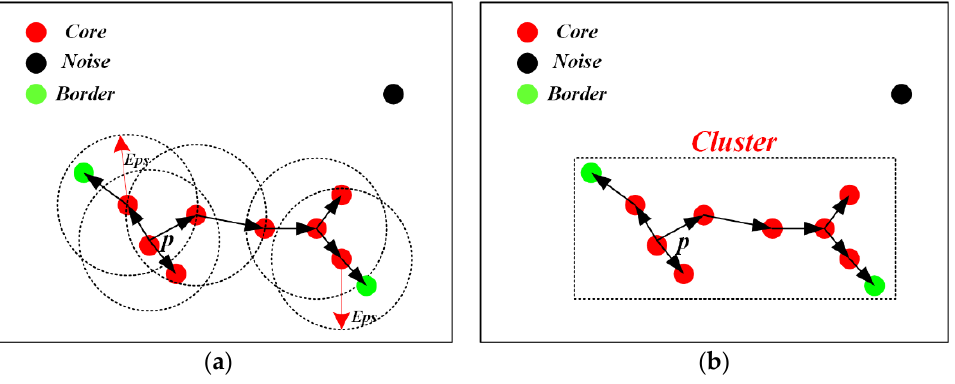
Figure 2. The principle of the DBSCAN algorithm. ( a ) All points density-reachable from the given point 𝑝 , ( b ) the given point 𝑝 and its density-reachable points forming the cluster.